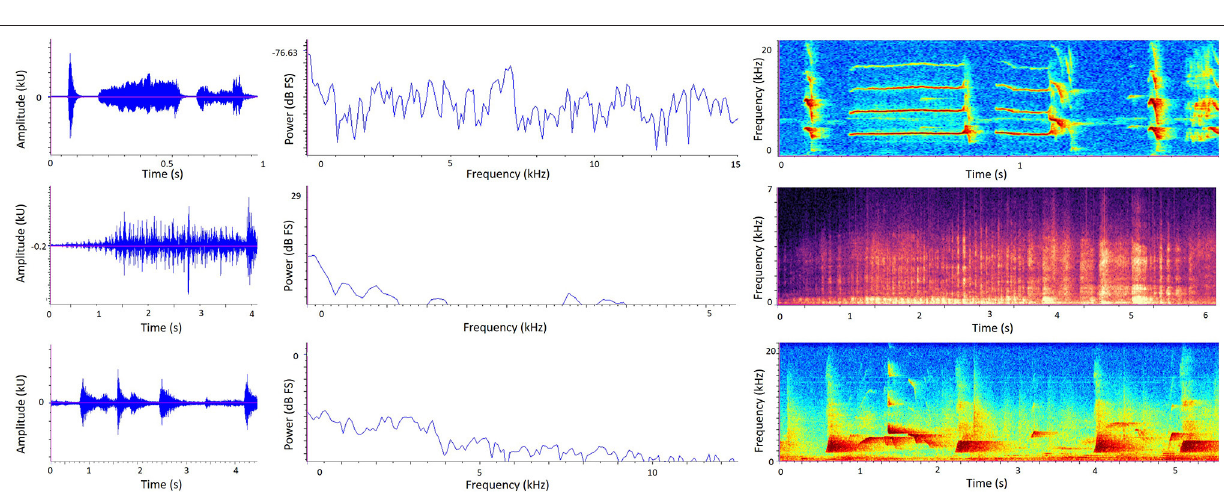
FIGURE 3 | Sound visualization graphs generated from sound recordings in zoos. Left to right: Oscillogram, Power spectrum, Spectrogram. Top: Golden lion tamarin ( Leontopithecus rosalia ) calls in the absence of background sound. Middle: A zoo soundscape containing biophonic (bird calls) and anthrophonic (human speech) elements. Bottom: Western lowland gorilla ( Gorilla gorilla gorilla ) calls in the absence of background sound. Note differently scaled axes to best suit different species and environment. In the spectrograms (right), color intensity represents amplitude. Here, darker colors represent lower amplitude and lighter colors represent higher